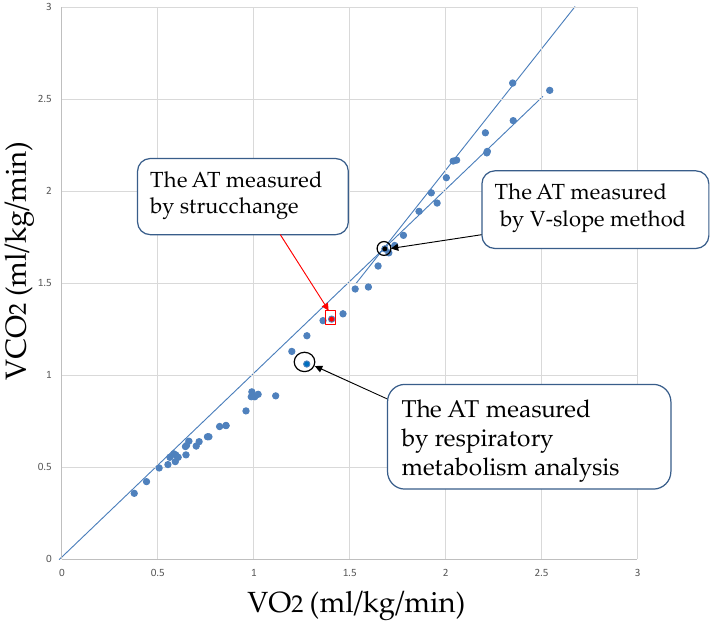
Figure 5. Comparison of each AT for subject K by the V-slope method, strucchange, and respiratory metabolism analysis.